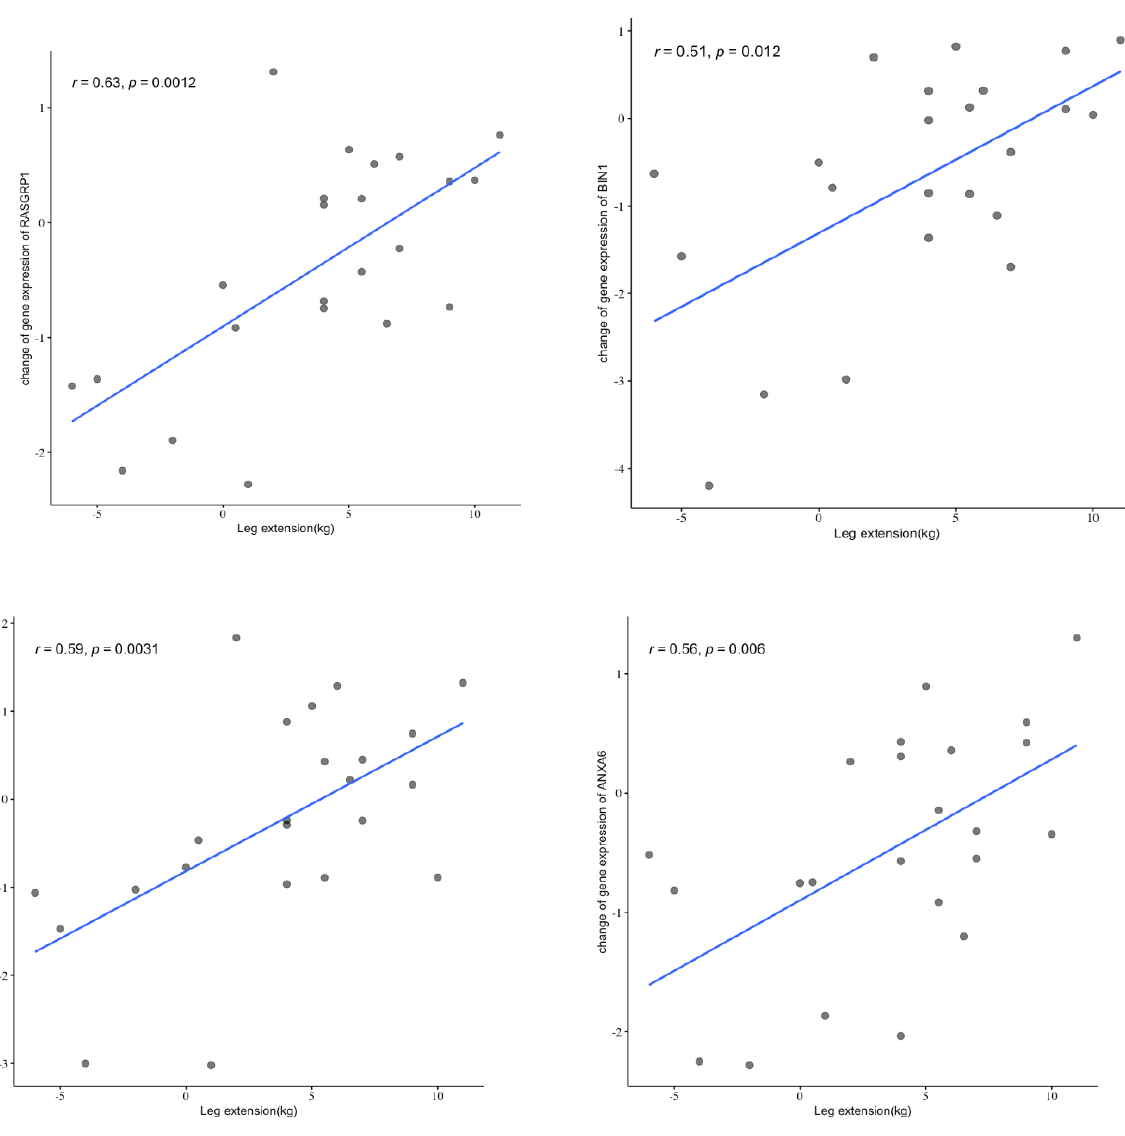
Figure 2. Figure showing the correlation between changes in gene expression and leg extensions in combined